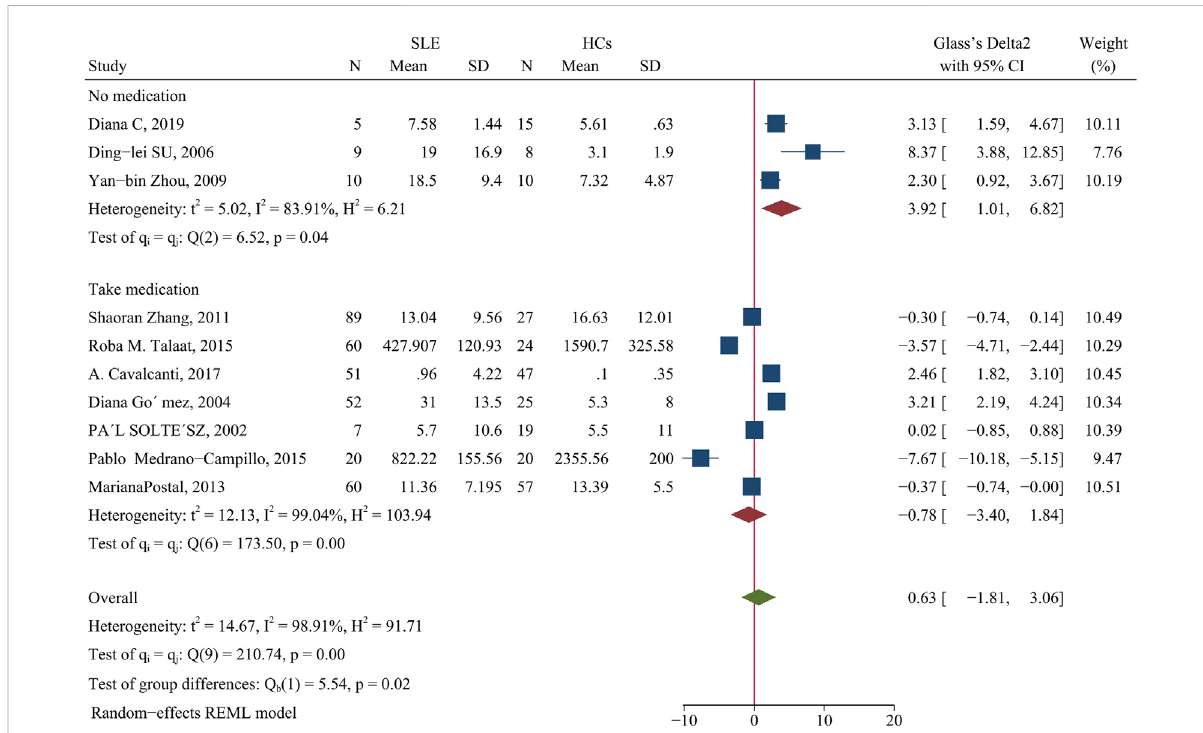
healthy controls.